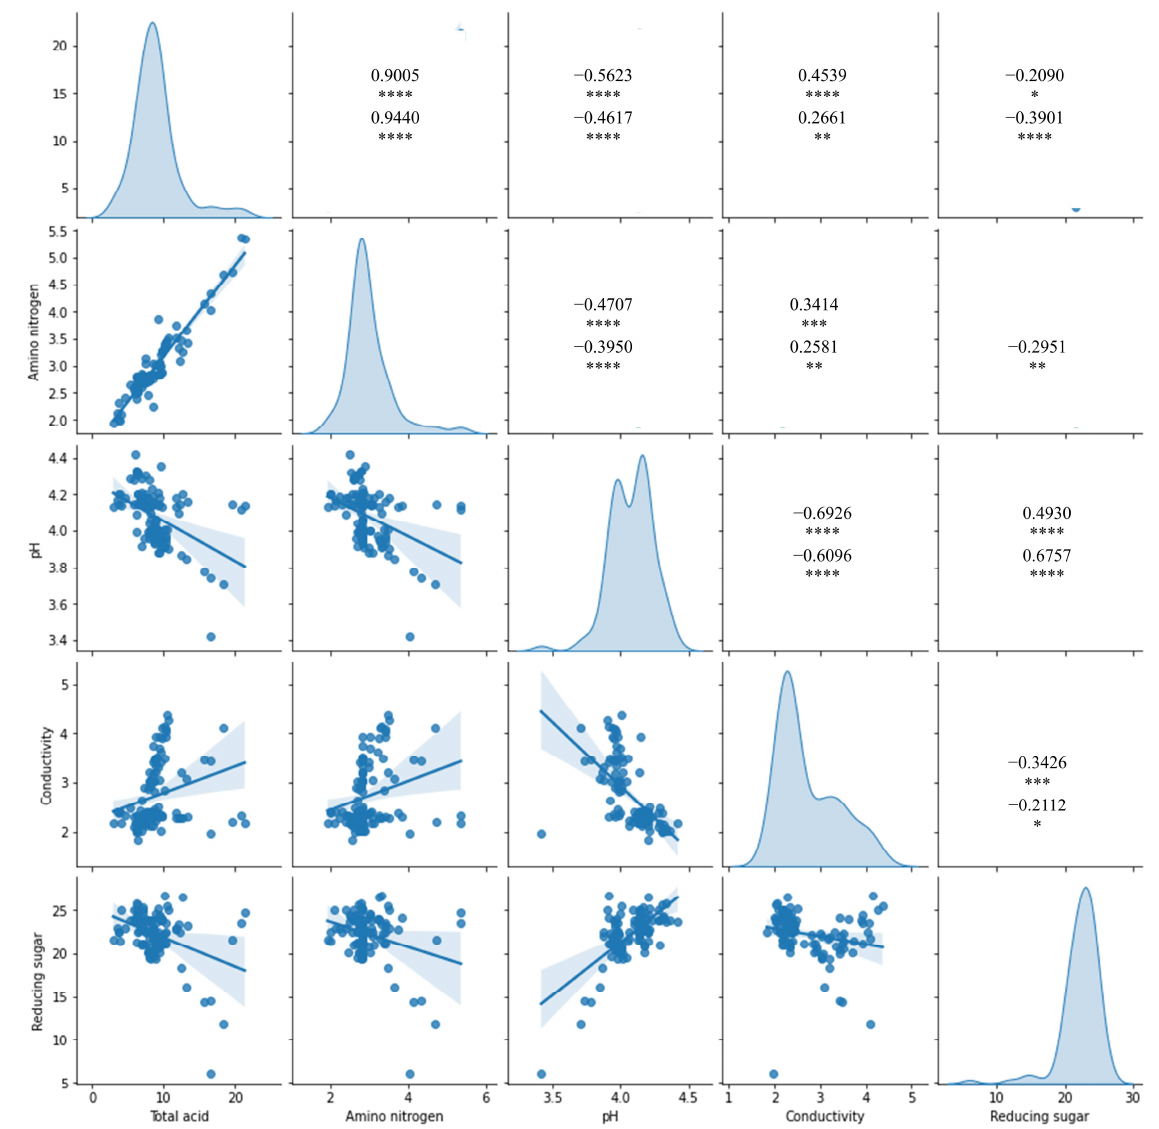
Figure 1. Dot plots of the physiochemical indexes of age huangjiu samples. Panels on the diagonal show the distribution of physiochemical indexes. Figures in the top right are Spearman ρ, Spearman r , Pearson p , and Pearson r from top to bottom, respectively. *: r < 0.1; **: r < 0.05; ***: r < 0.01; ****: r < 0.001.